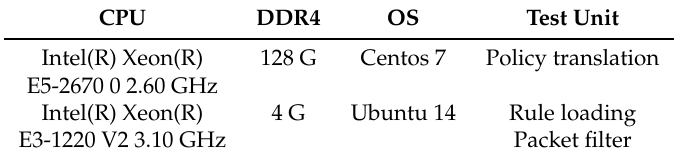
Figure 7. Operation interface. ( a ) map from policy to rule and distribution; ( b ) add policy configuration; ( c ) packet filter execution. Table 1. The Relation between test unit and running environment of hardware.